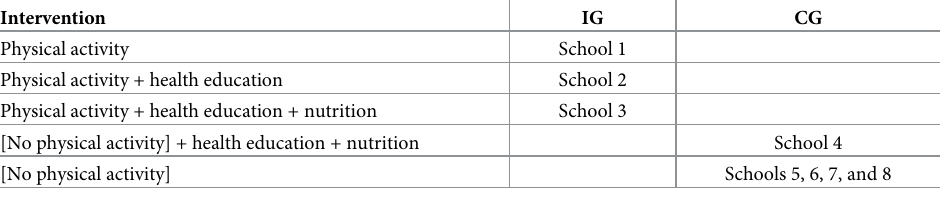
Table 1. Intervention measures at the eight primary schools in Port Elizabeth, South Africa carried out between February 2015 and May 2016.